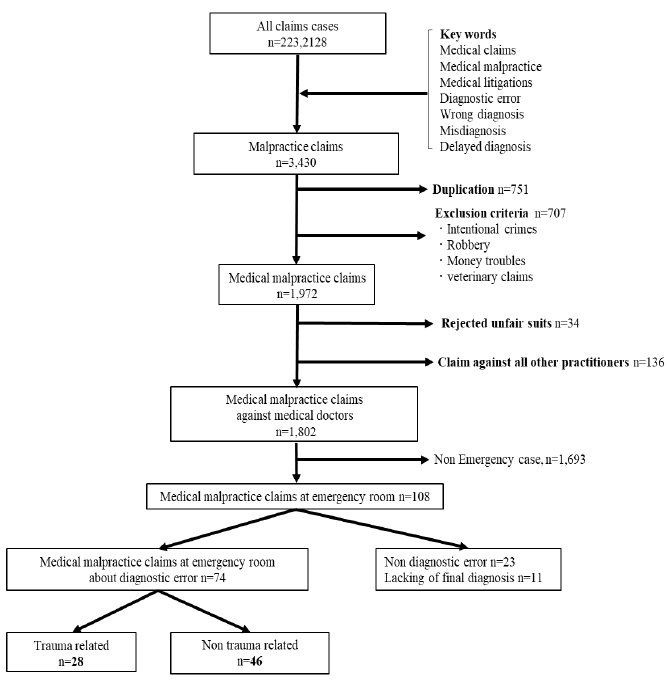
Figure. Participant flowchart. Medical lawsuits in Japan from 1961-2017.* *From the total number of lawsuits, “medical claims,” “medical malpractice,” “medical litigation,” “diagnostic error,” “wrong diagnosis,” “misdiagnosis,” and “delayed diagnosis” were used as keywords to identify cases. Exclusion criteria and unfair suits were defined as claims that a lawyer decides are